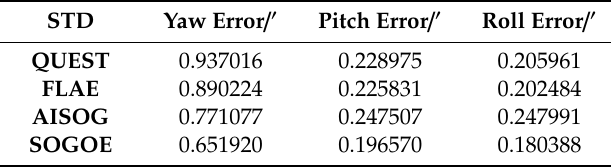
Table 3. Standard deviation of the steady-state